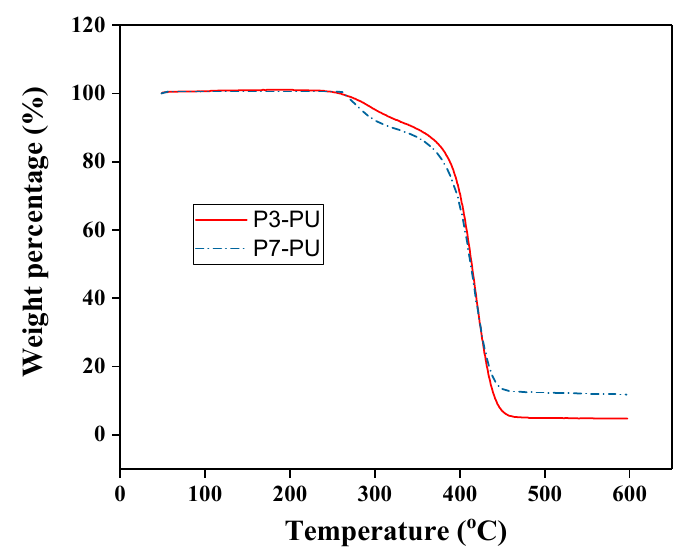
Figure 8. Thermogravimetric analysis (TGA) curves of P3-PU and P7-PU .